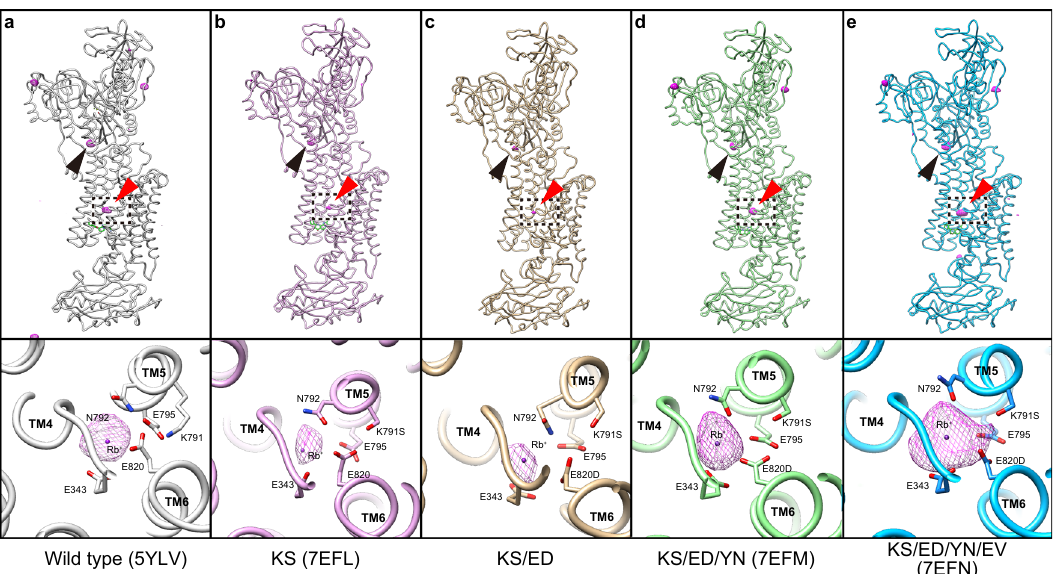
Fig. 2 Rb + anomalous density maps. a – e Whole enzyme structures of wild type in SCH·K + ·E2BeF form ( a , 5YLV) and indicated mutants in BYK·K + ·E2BeF form b – e are shown in the upper row. Close-up of the cation-binding sites (dotted boxes), viewed from the cytoplasmic side, are shown in the lower row. Purple mesh represents anomalous difference Fourier maps from Rb + in the asymmetric unit of the crystals, contoured at 4 σ . Anomalous densities responsible for the bound Rb + at the TM cation-binding site, and P domain are indicated as red and black arrowheads,